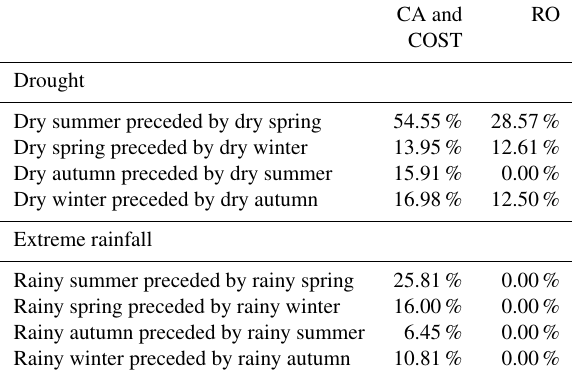
Table 2. Temporal coincidence of drought and extreme rainfall val- ues between consecutive seasons. Each cell shows the percentage of dry/rainy seasons that were preceded by dry/rainy seasons. Note: different colours symbolise how much the values deviate above (from white to red) or below (from blue to white) from the 50th percentile of the data,